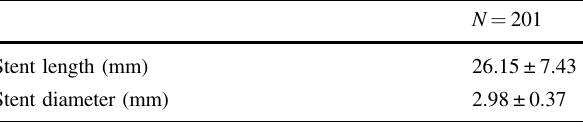
Table 2 Baseline characteristics of subjects